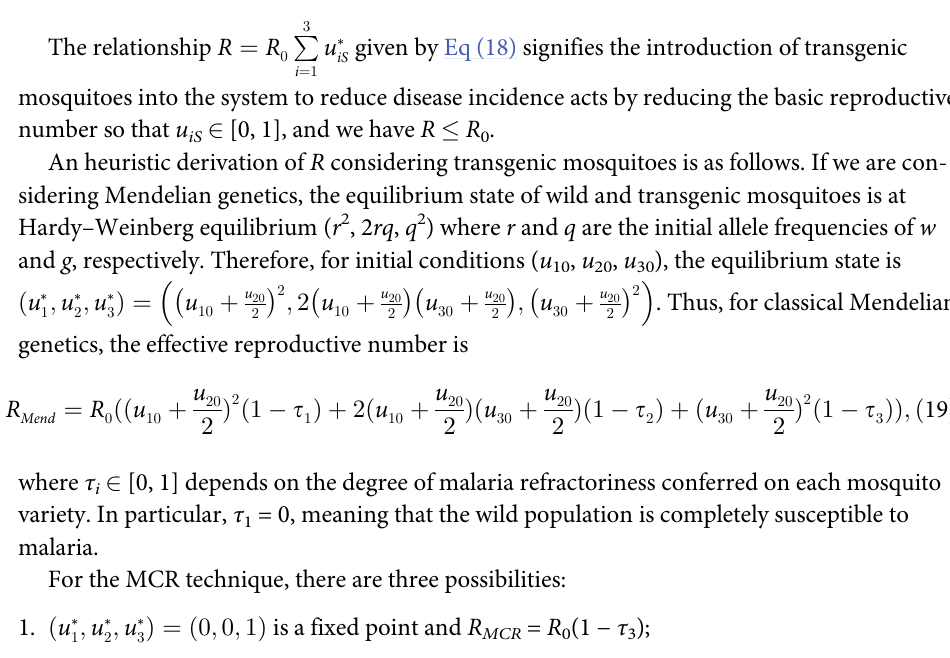
Fig 1. Illustration of the possible behaviors of the isoclines u 1I and h I . Initial slope of u 1 above the slope of h I isocline